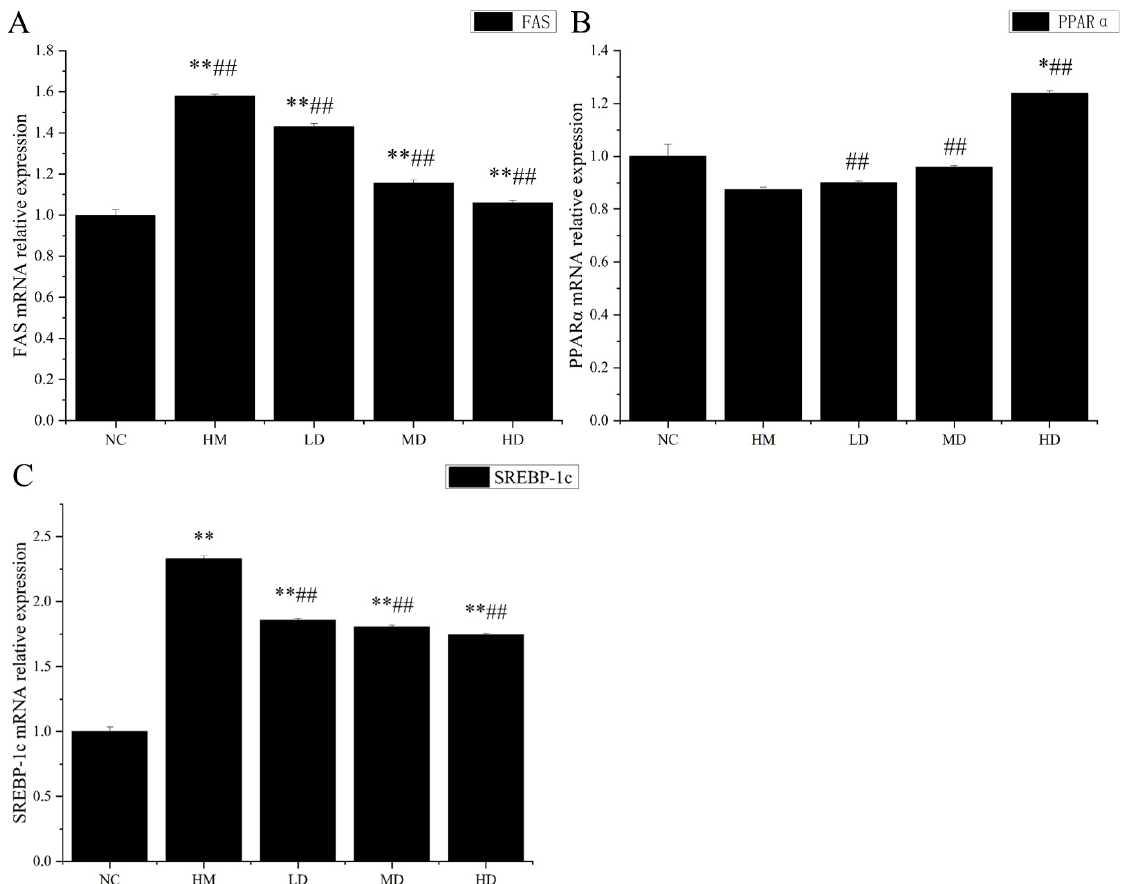
Figure 4. ( A ) Effects of naringin on FAS mRNA relative expression in mouse liver (the results of FAS Figure 4. （ A ） Effects of naringin on FAS mRNA relative expression in mouse liver （ t he results of FAS mRNA expression in liver tissue ） . (B) Effects of naringin on PPAR α mRNA expression in mRNA expression in liver tissue). ( B ) Effects of naringin on PPAR α mRNA expression in mouse liver mouse liver （ the results of PPAR α mRNA expression in liver tissue ） . (C) Effects of naringin on (the results of PPAR α mRNA expression in liver tissue). ( C ) Effects of naringin on SREBP-1c relative SREBP-1c relative expression in mouse liver （ the results of SREBP-1c mRNA expression in liver expression in mouse liver (the results of SREBP-1c mRNA expression in liver tissue). Note: n = 8; tissue ） . Note: n = 8; * P < 0.05, ** P < 0.01 compared with those in the blank control. # P < 0.05, ## P < 0.01 compared with those in the model group. * p < 0.05, ** p < 0.01 compared with those in the blank control. ## p < 0.01 compared with those in the model